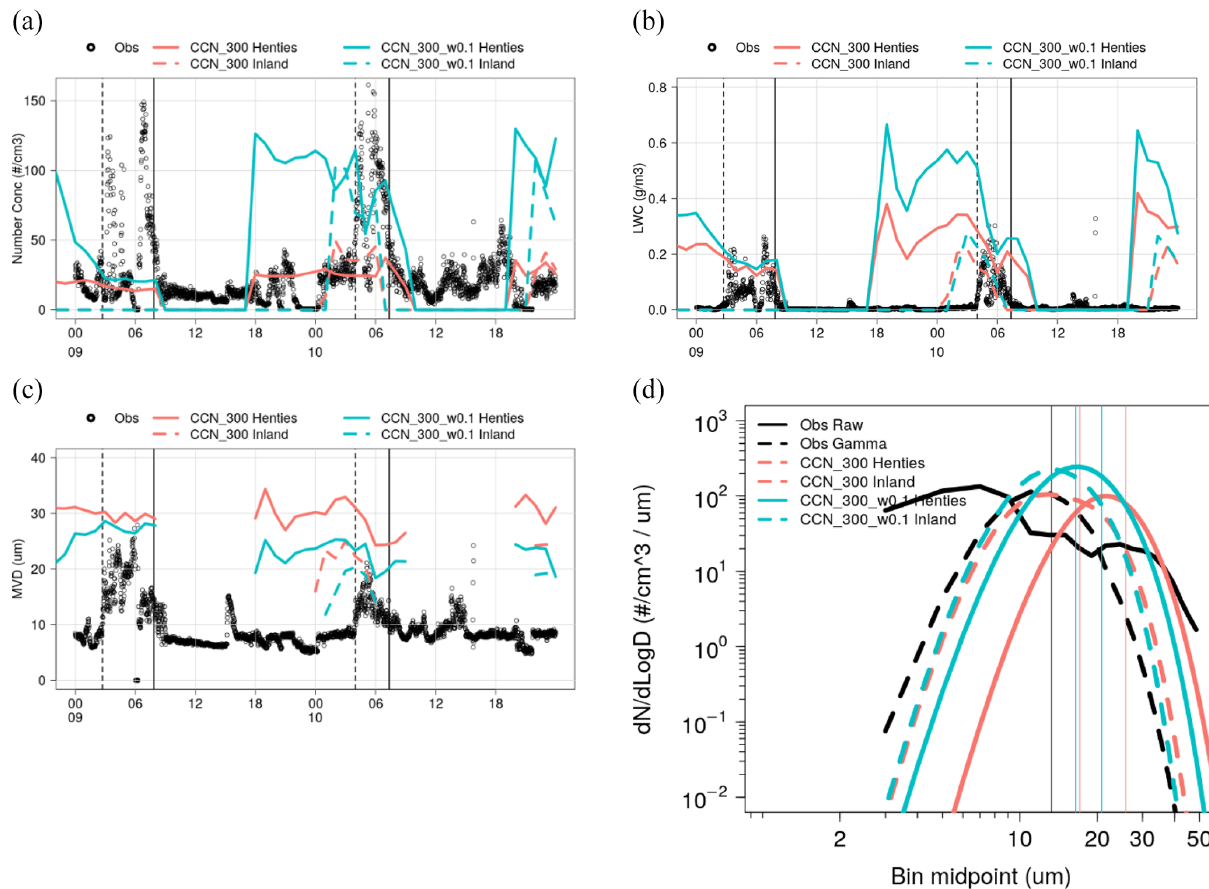
Figure 21. Observed and modelled DSD for (a) case 1 and (b) case 2. Black solid lines are the observed distributions. Black dashed lines are the equivalent theoretical gamma distribution applied to the observed data. Remaining dashed lines are model distributions. Vertical solid lines represent the MVD. Time is in UTC (site is UTC +